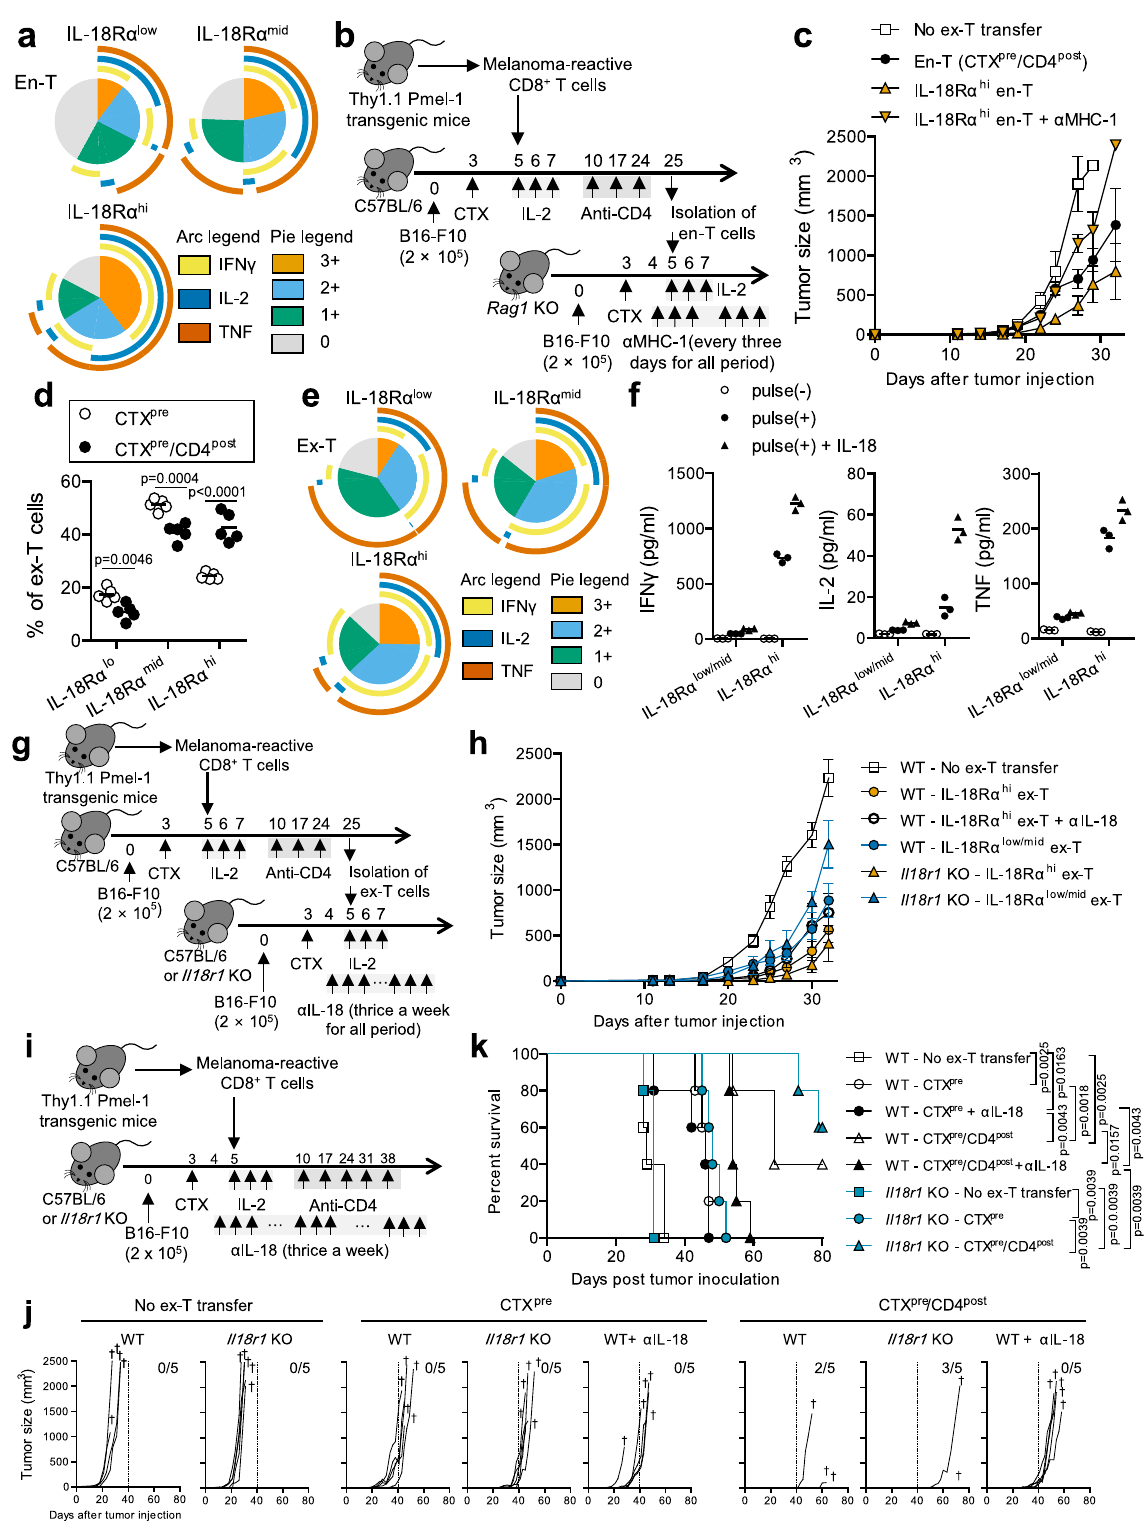
the CTX pre /ACT/CD4 post -induced milieu in the long-term by blocking the IL-18 signal, which played a crucial role in the function of IL-18R α hi CD8 + T cells in vitro and in vivo (Fig. 5f, h). Il18r1 KO mice (in which IL-18 signaling is absent in the cells in recipient mice, whereas it is intact in transferred ex-T cells) or IL-18 neutralizing antibody (which blocks IL-18 signaling) were used to abrogate the function of IL-18R α hi en-T or en-T/ex-